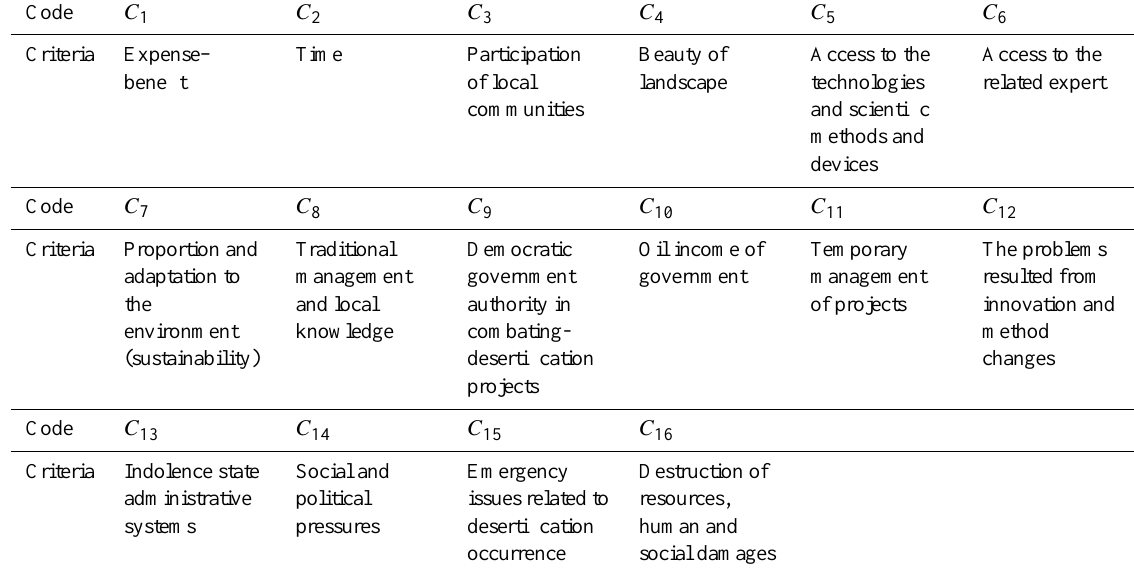
Table 1. The criteria and their importance mean according to the group. Code